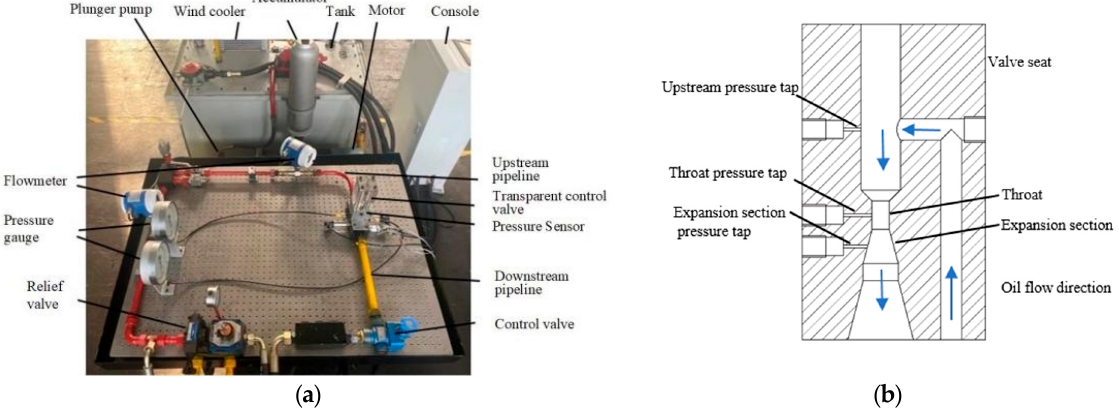
Figure 1. ( a ) Schematic diagram of the hydraulic system. ( b ) Flow channel structure and schematic diagram of three monitoring